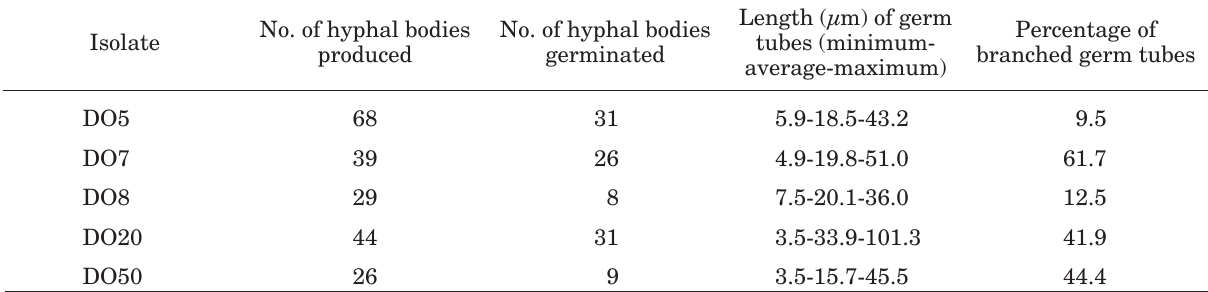
Table 1. Characteristics of germinated hyphal bodies of Pythium spiculum isolates observed microscopically on 8 mm 2 areas of glass